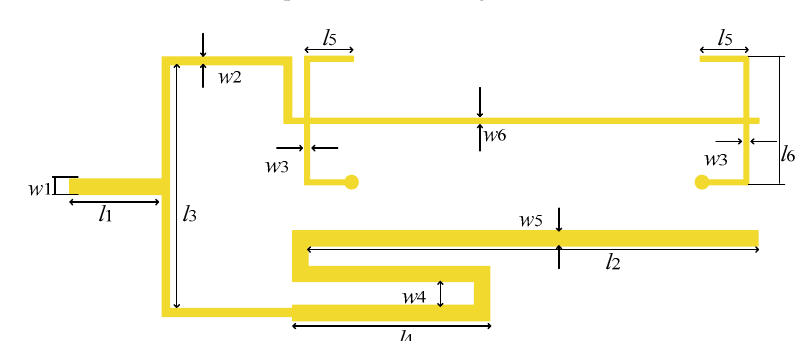
Figure 3. Equivalent circuit diagram of the balun.